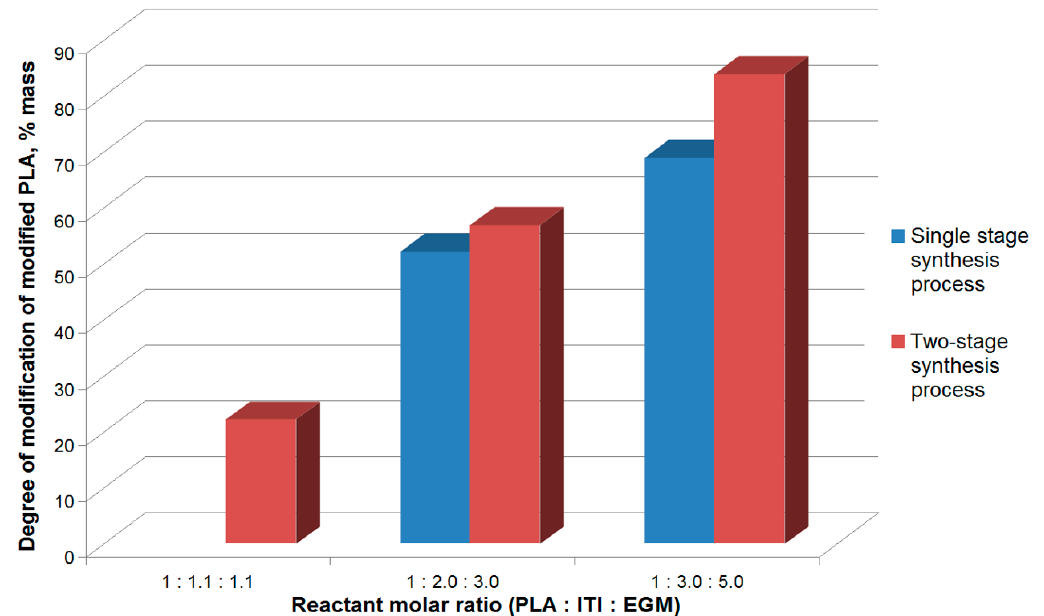
Figure 9. Average methacrylated PLA degree of modification in single-stage and two-stage reactions of PLA modification in the scCO 2 (supercritical carbon dioxide) medium (40 ° С , 9 MPa) at different ratios of initial components, calculated by the formula (1).